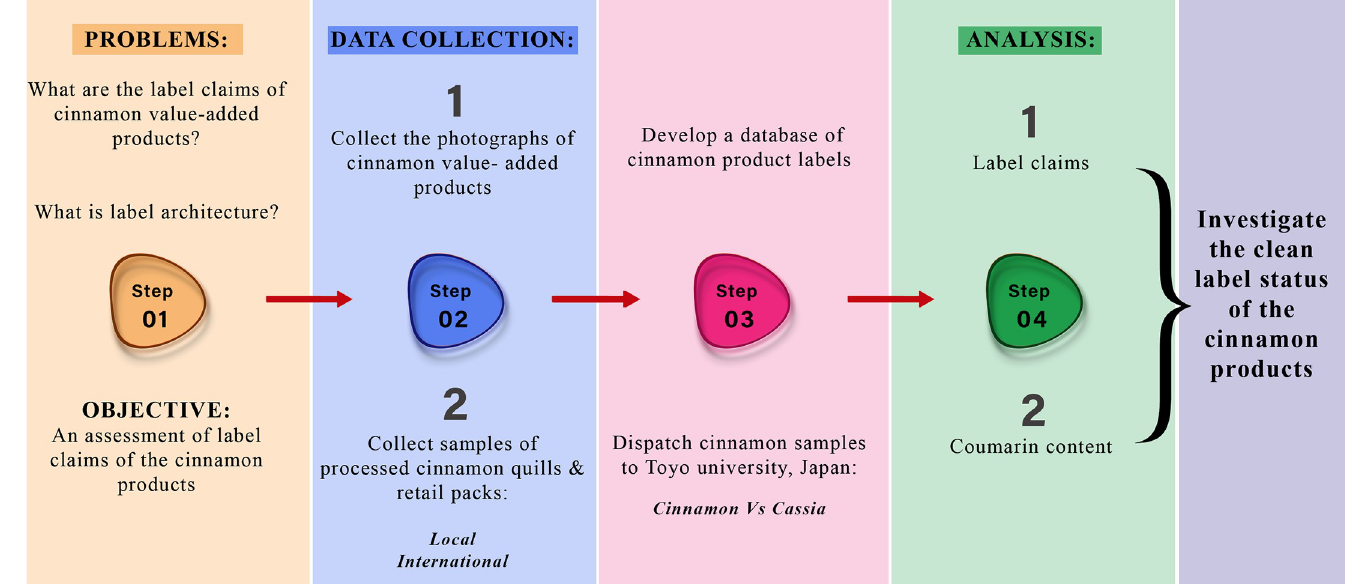
Fig 3. Process of the